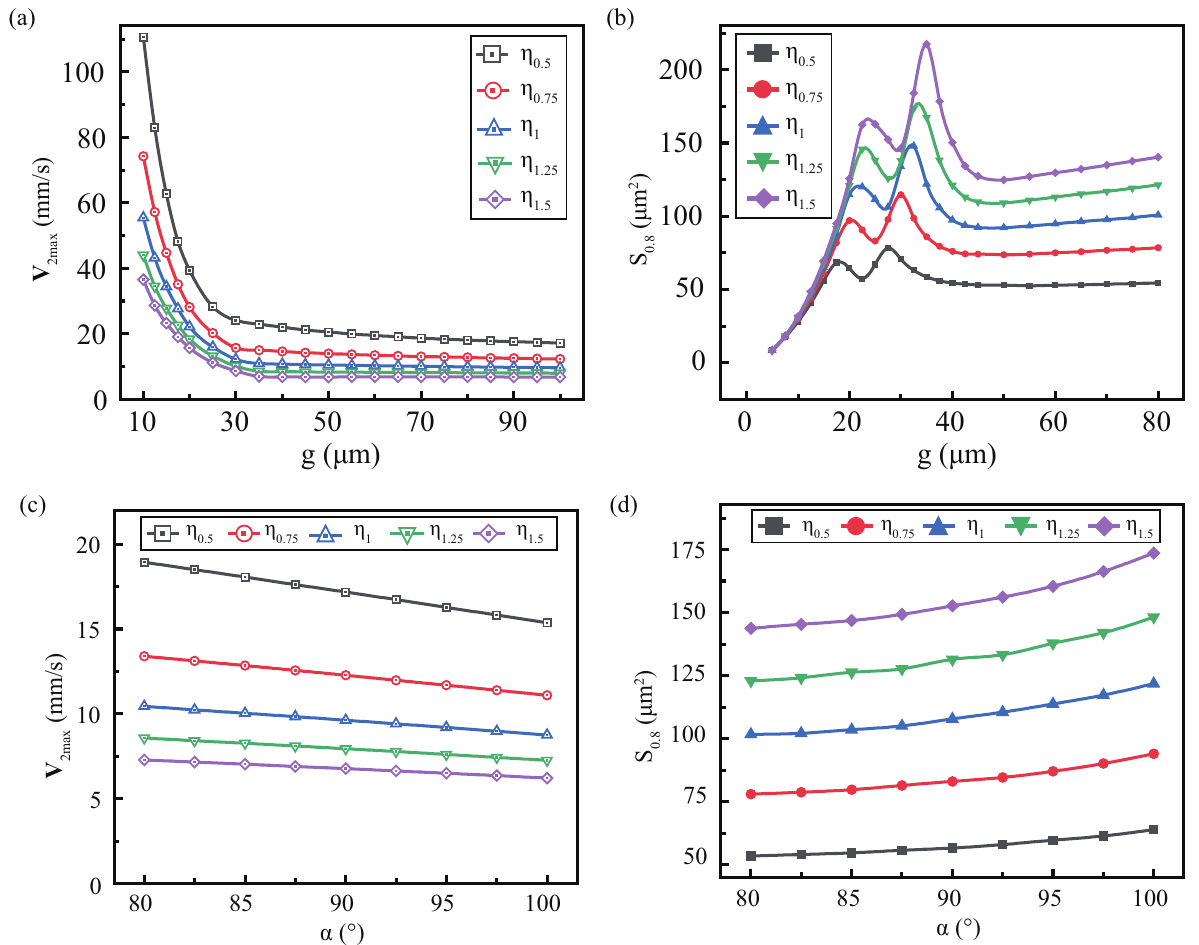
Figure 10. Effect of side profile parameters on streaming under viscous viscosity. There are the effect of the gap on the maximum streaming velocity ( a ) and effective area ( b ), as well as the effect of the sidewall angle on the maximum streaming velocity ( c ) and effective area ( d